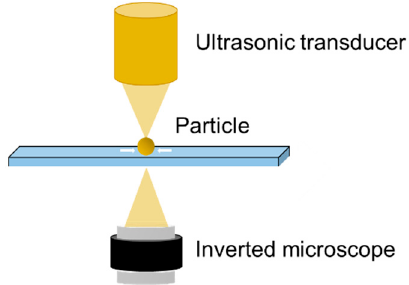
Figure 12. Schematic diagram of acoustic tweezers.